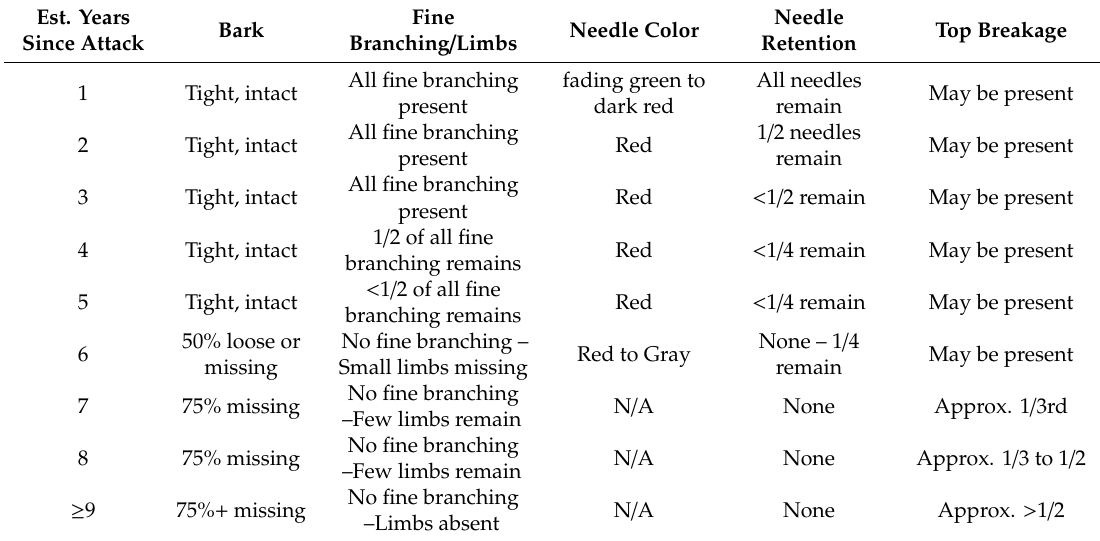
Table A1. Field protocol for estimating years since death of dead trees based on needle, branch, and snag condition.